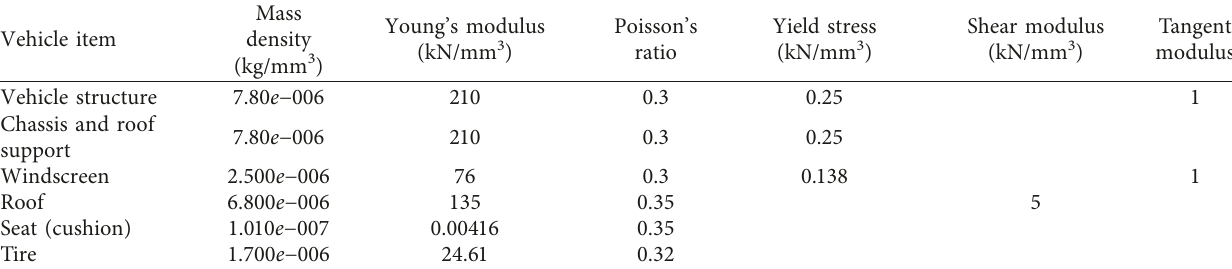
Table 1: Mechanical properties of the vehicle component.